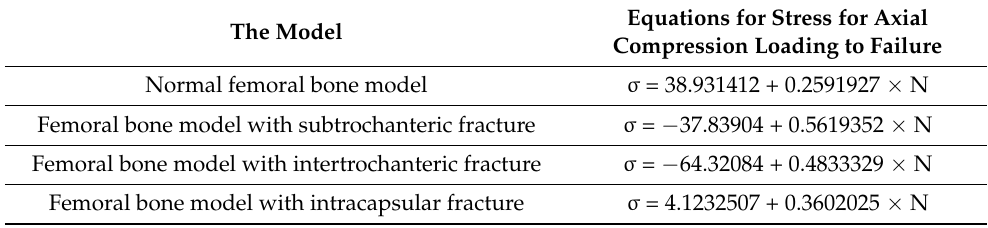
Table 2. Equations for stress in axial compression loading to failure.